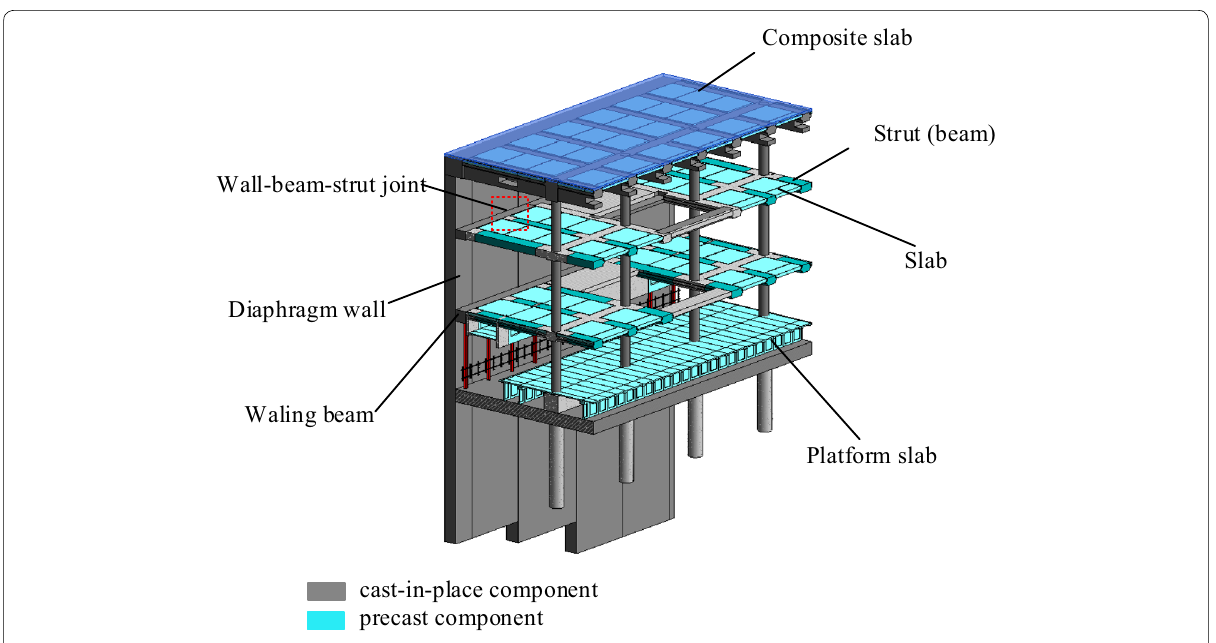
Fig. 1 Prototype of the prefabricated metro station.